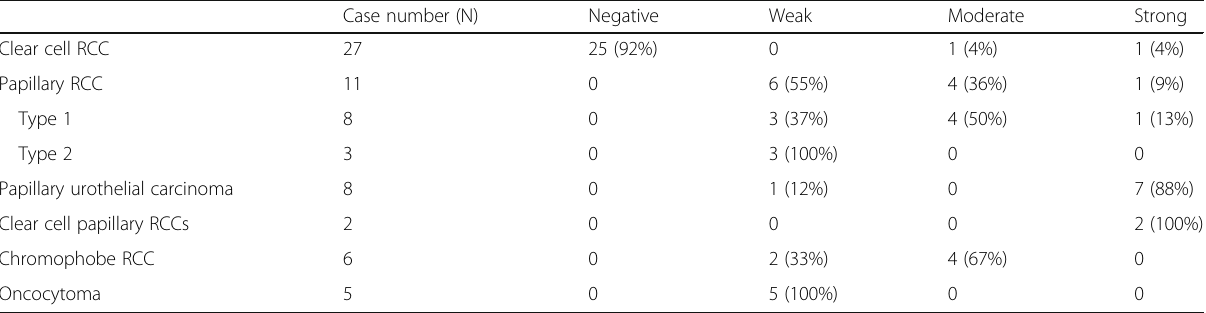
Table 1 The expression of TGR5 in RCCs